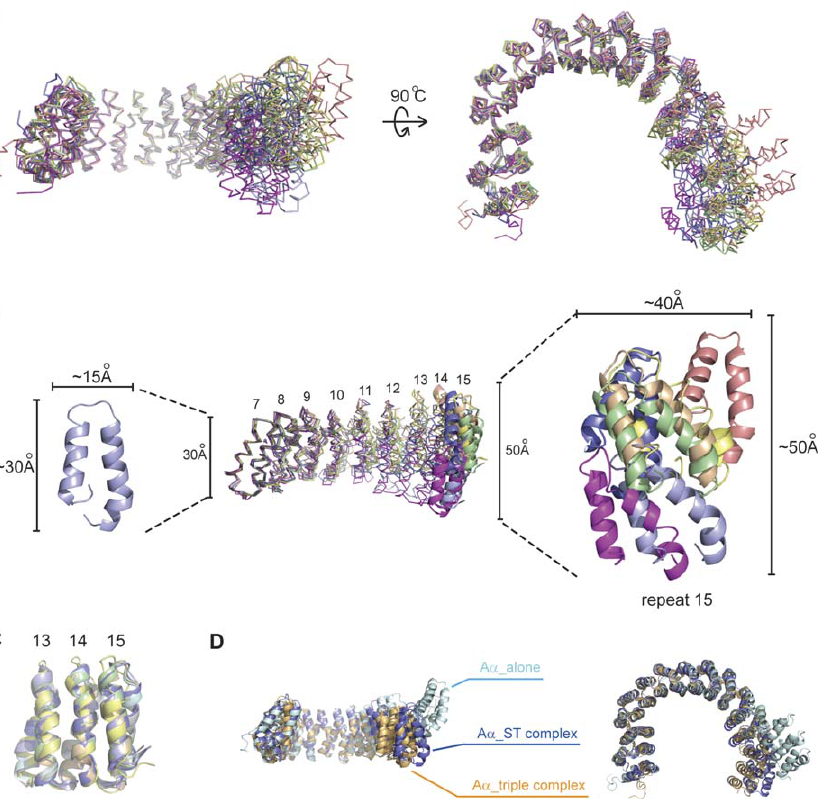
Figure 6. Structural Comparison of the PP2A A Subunit and the Structural Flexibility (A) The structural alignment of PP2A A subunits. PP2A A subunit structures were aligned based on their structures of HEAT repeats 2–10. PP2A A subunit structures that used for the alignment are from the four A-ST complexes in the asymmetric unit, the A subunit structure alone (PDB code: 1B3U), the AC dimer structure (PDB code: 2IE3), and the A-B56-C trimeric structure (PDB code: 2IAE). The HEAT repeats 2–10 may form a rigid structural block since no significant structural variations were observed for this region among all A subunit structures. (B) The amplitude of conformational variations of the PP2A A subunit HEAT repeats 11–15. (C) HEAT repeats 13–15 may form the other relatively rigid structural block in the PP2A A subunit. There is no major conformational variation in HEAT repeats 13–15 among all A subunit structures. Therefore, the structural variations observed in (A) and (B) are mostly due to the conformational flexibility of HEAT repeats 10–13. (D) Superposition of PP2A A subunit structures from A a alone, A-ST complex, and A-B56-C trimeric complex. The structure of the PP2A A subunit in the A-ST complex can have a conformation very similar with that of the A subunit in the A-B56-C trimeric complex.